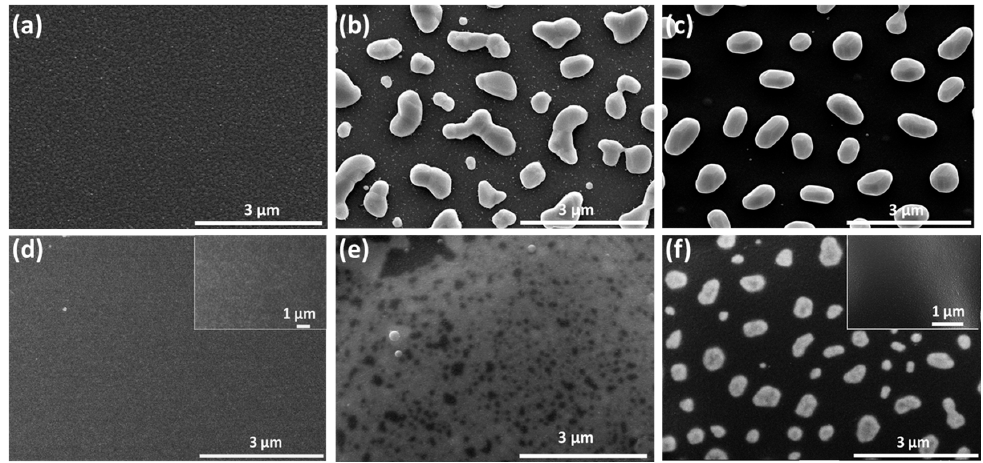
Figure 2. Surface topography of Pt/LGS samples ( a ) before high temperature measurement; and ( b ) after 800 °C resistance measurement; and ( c ) after 1000 °C resistance measurement; Surface topography of AlN/Pt/LGS samples ( d ) before high temperature measurement; and ( e ) after 800 °C resistance measurement; and ( f ) after 1000 °C resistance measurement. Insets shown in ( d ); and ( f ) present the surface topography of AlN/LGS samples before and after 1000 °C resistance measurement, respectively.